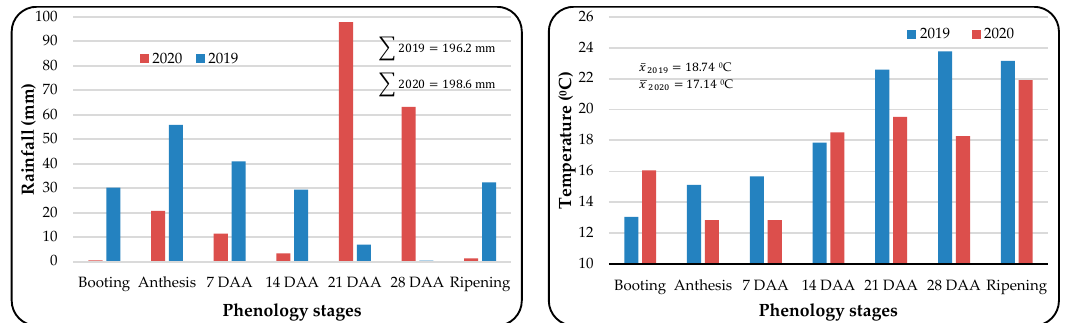
Figure 1. Climatic condition during the experimental period.